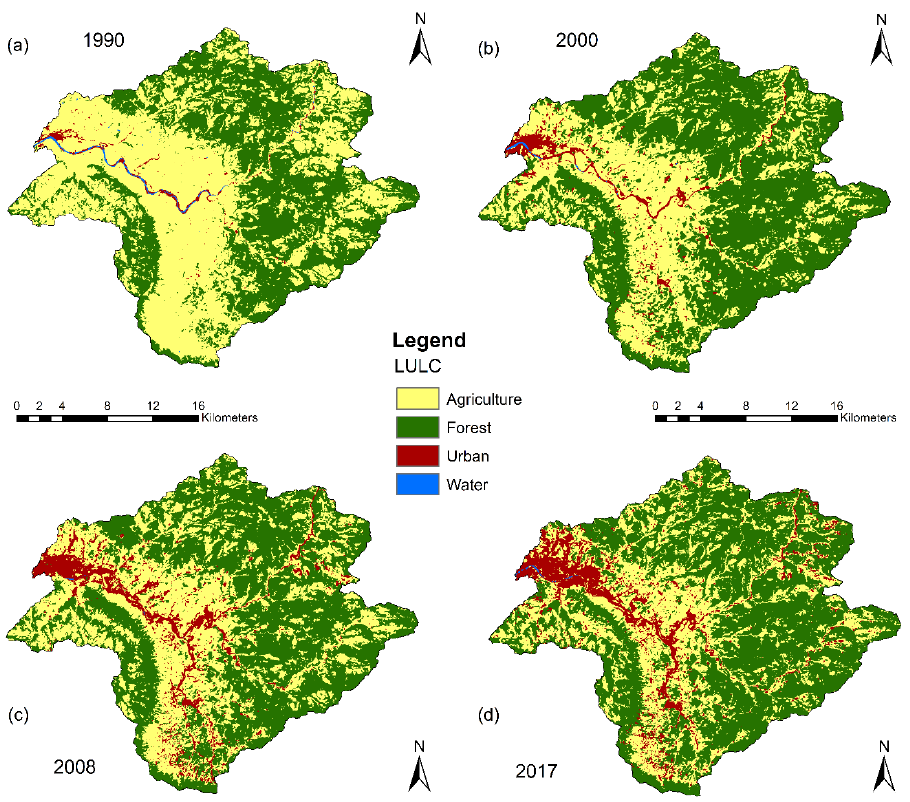
Figure 6. Land use land cover maps of the Guangyuan catchment for ( a ) 1990, ( b ) 2000, ( c ) 2008 and ( d ) ( d ) 2017.